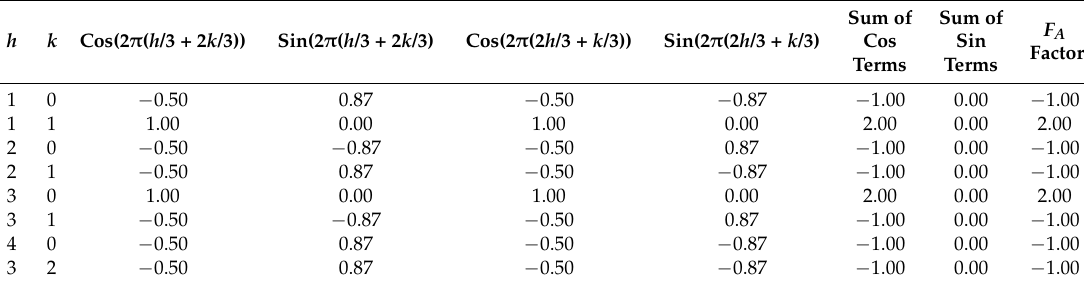
Table 2. Structure factor calculations in Equation (10).